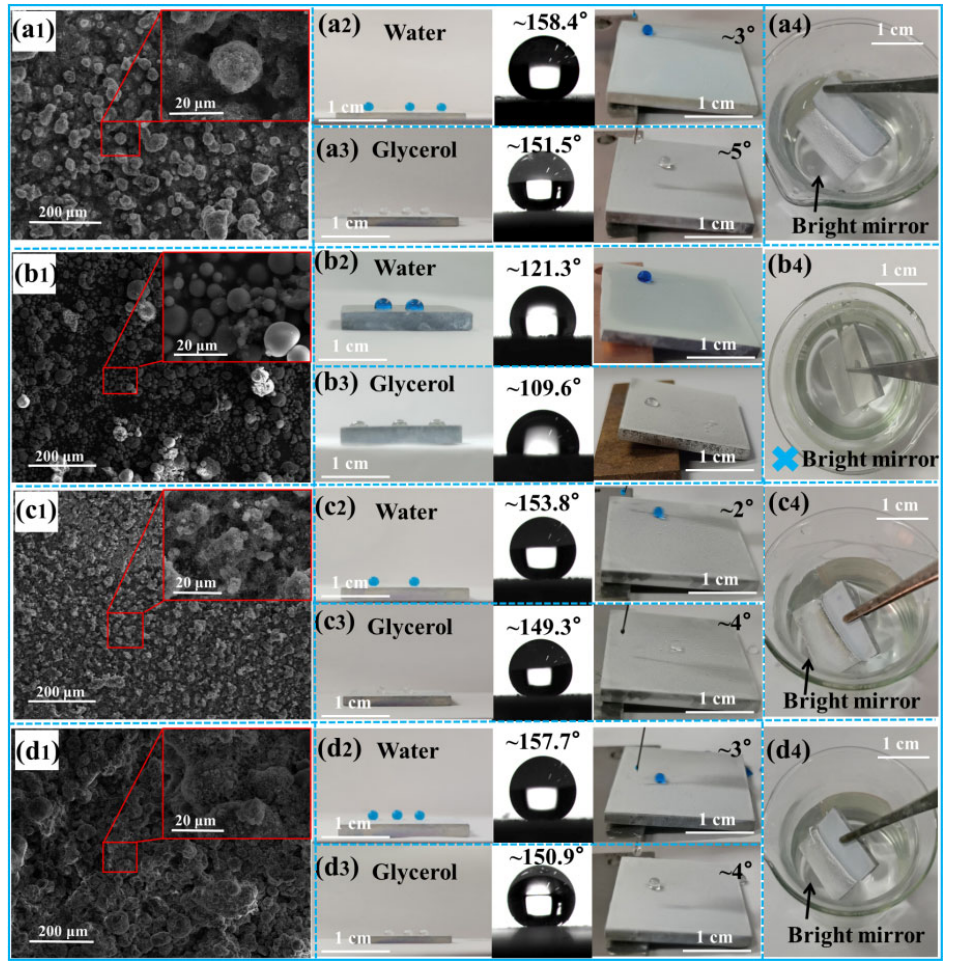
Fig. 2 SEM images of (a1) decoupling, (b1) micro, (c1) nano, and (d1) coupling coatings. Optical photographs, CAs, and RAs of water and glycerol droplets on (a2, a3) decoupling, (b2, b3) micro, (c2, c3) nano, and (d2, d3) coupling coatings. Optical photographs of (a4) decoupling, (b4) micro, (c4) nano, and (d4) coupling coatings immersion into